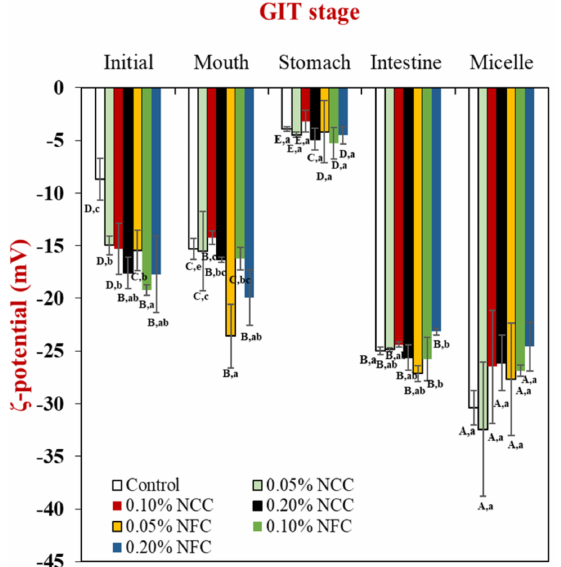
Figure 5. Influence of nanocellulose and gastrointestinal tract (GIT) stage on ζ -potential of 10% ( w / w ) O/W emulsions containing β -carotene. Samples designated with different capital letters (A–E) were significantly different (Duncan, p < 0.05) when compared between different GIT stages (same stabilizer). Samples designated with different lowercase letters (a–c, e) were significantly different (Duncan, p < 0.05) when compared between different stabilizer (same GIT stage).